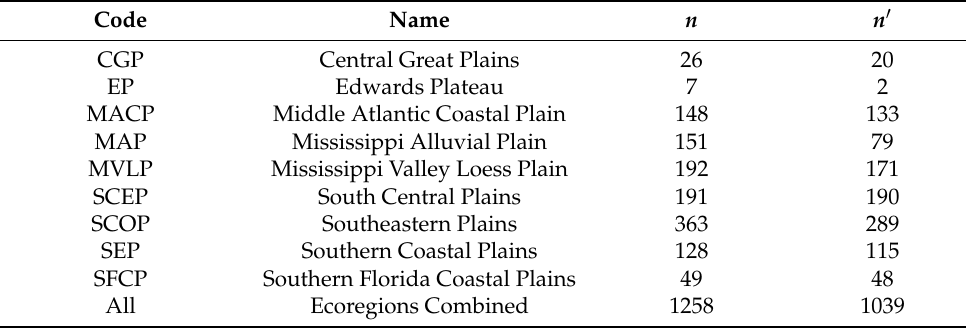
Table 2. Brief ecoregion descriptions; adapted from Wiken et al. [18].